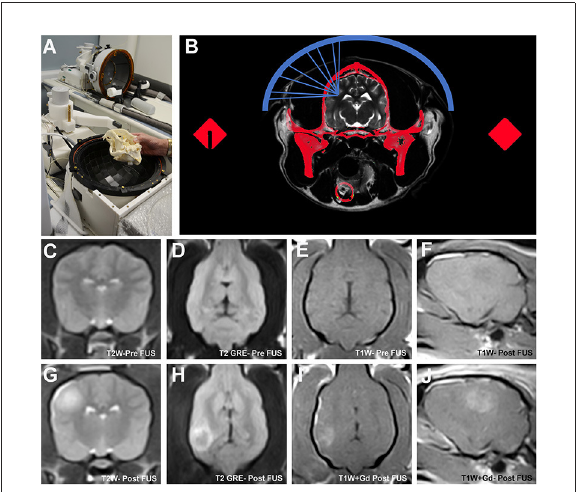
FIGURE6 Transcranial magnetic resonance image guided focused ultrasound BBBD (MRg-FUS-BBBD) in the dog. Representative canine skull placed into a hemispherical phase-array